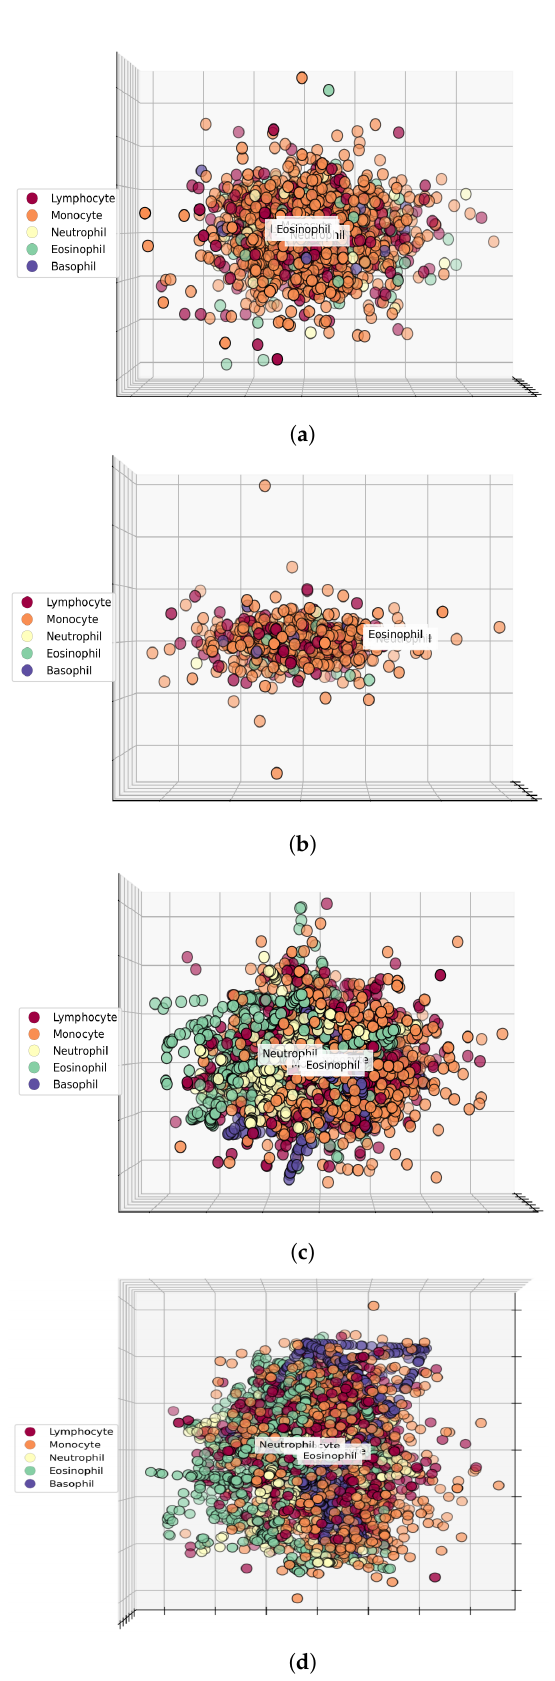
Figure 8. Comparison of original features space and proposed features space. We visualize features in 3D space and show that the features set makes a good correlation with target classes or not. If